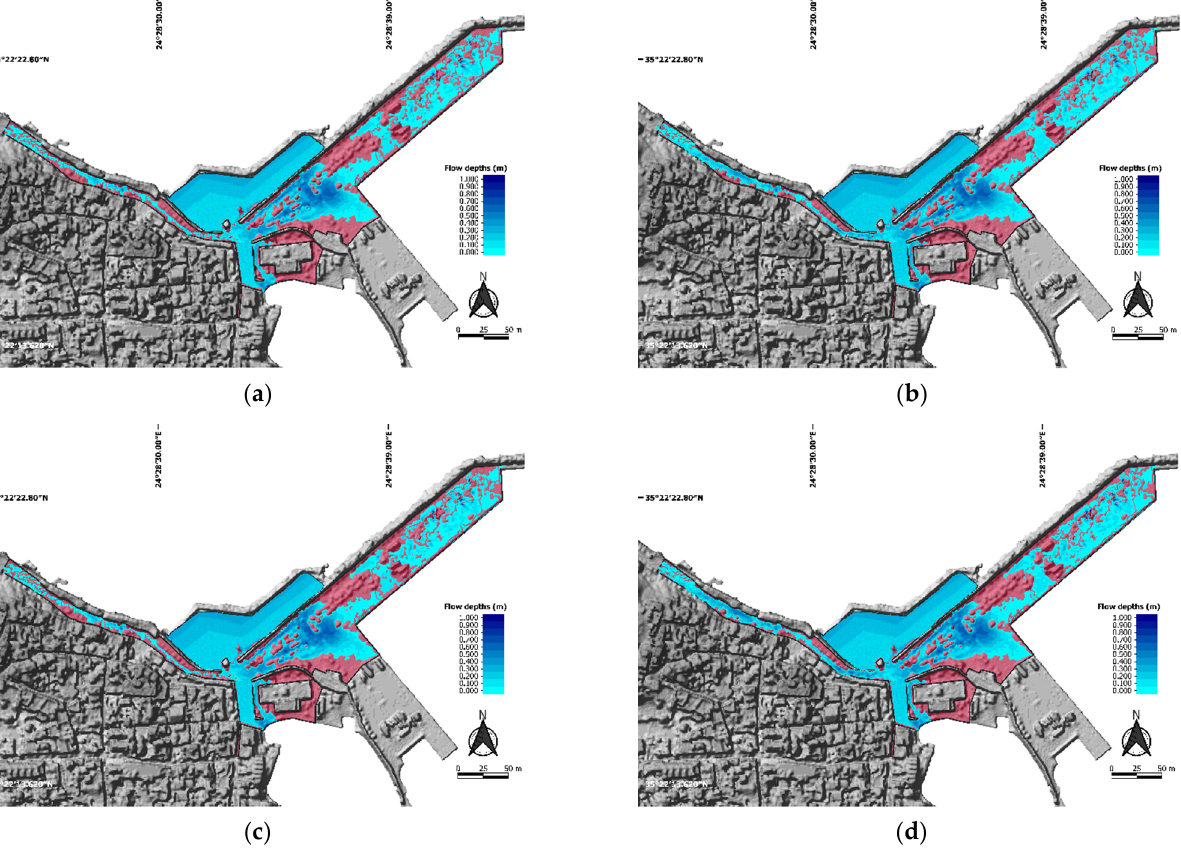
Figure 6. Inundated areas according to simulation results (highlighted with blue color palette) for storm events: ( a ) S1, ( b ) S2, ( c ) S3 and ( d ) S4 on top of the maximum inundated area from video recordings and local stakeholders’ observations (highlighted with red color).